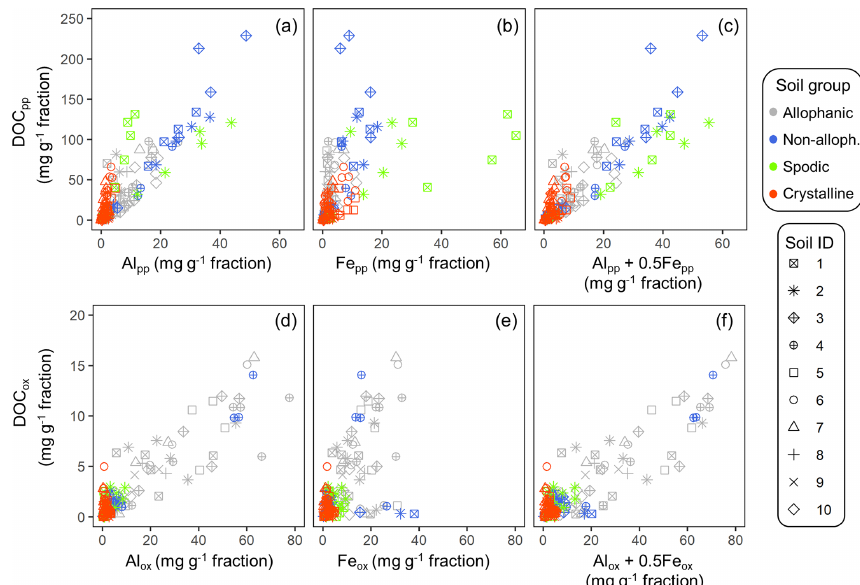
Figure 3. Scatter plot of extractable metals and co-dissolved organic C (DOC) for the density fractions from the studied soils. Pyrophosphate- extractable Al (a) , Fe (b) , and Al + 0.5Fe (c) against DOC OX in the upper panel. Oxalate-extractable Al (d) , Fe (e) , and Al + 0.5Fe (f) against DOC OX in the lower panel. Symbol color distinguishes the four soil groups and its shape corresponds to sample ID in Table 1.